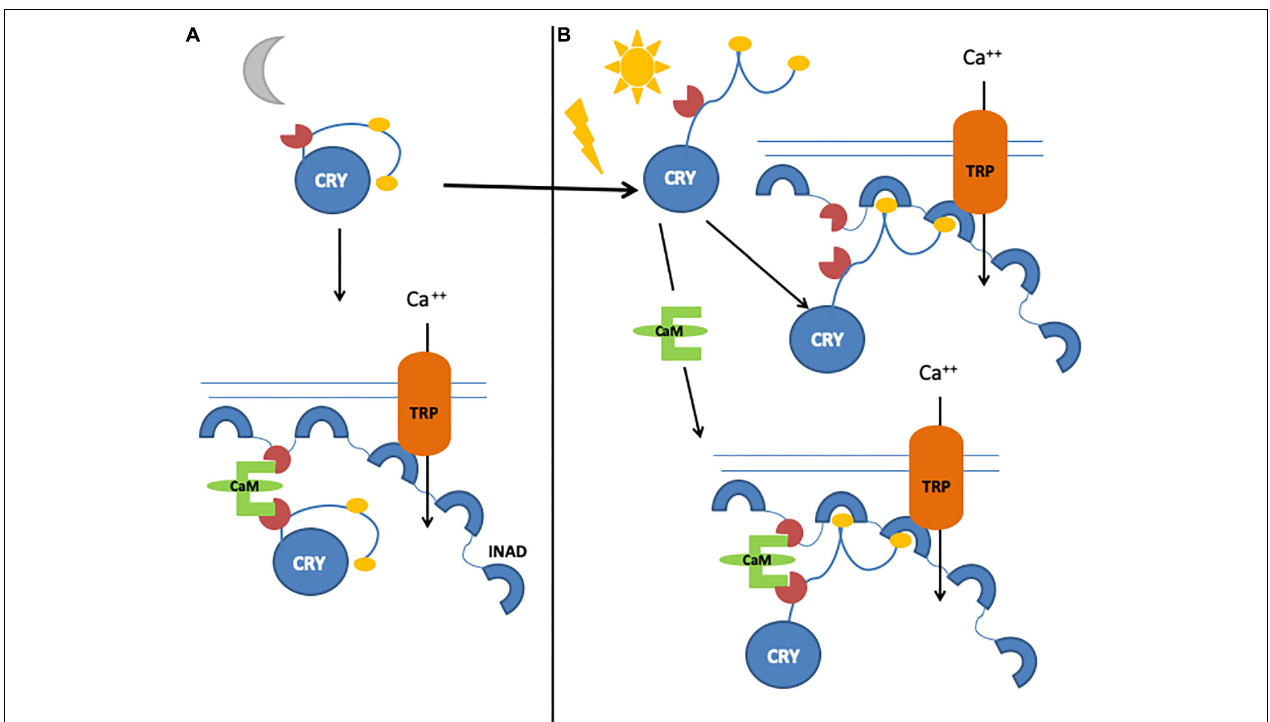
FIGURE 4 | Graphical representation of CRY/calmodulin interaction mechanisms. (A) Light-independent, CaM-dependent pathway. Inactive CRY binds to CaM, which allows the formation of a ternary complex with INAD. (B) In the presence of light, CRY can bind INAD directly. In the presence of both light and calmodulin, CRY–INAD binding is strengthened, thus consolidating the initial light-induced